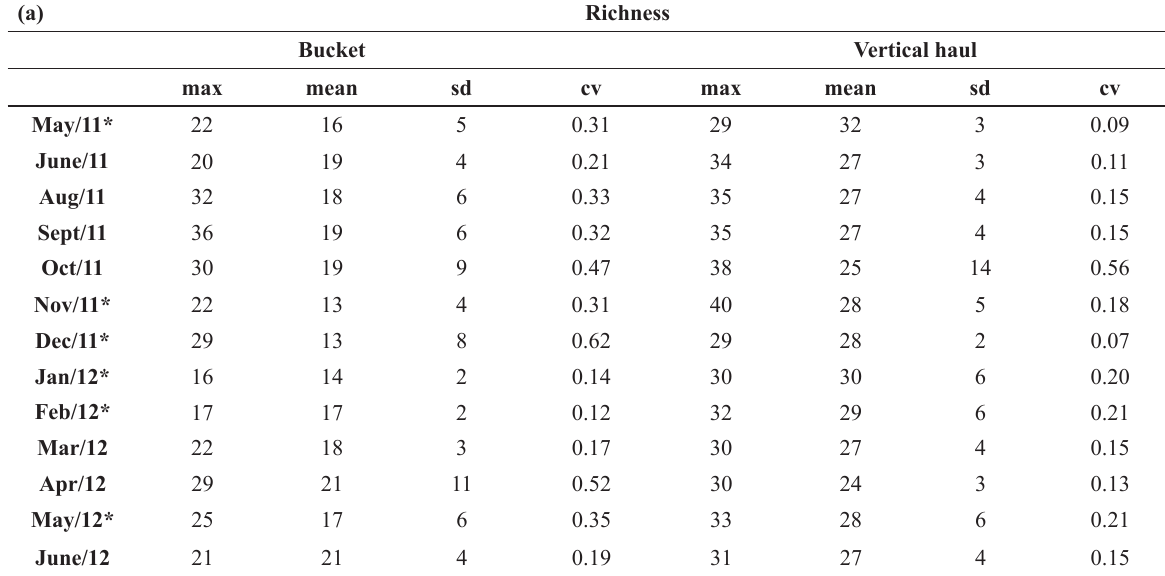
Total monthly zooplankton species richness (a) and density in ind.m -3 (b) (maximum, mean, standard deviation and coefficient of variation) in samples collected by bucket and by vertical